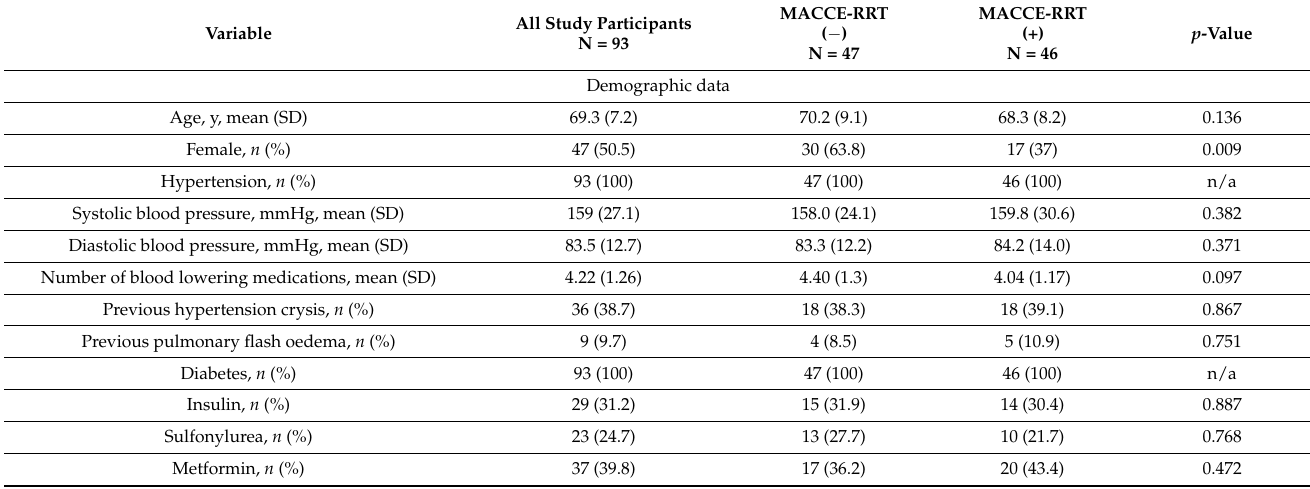
Table 1. Baseline characteristics of 93 study participants with atherosclerotic renal artery stenosis according to clinical, renal Doppler ultrasonography and angiographic